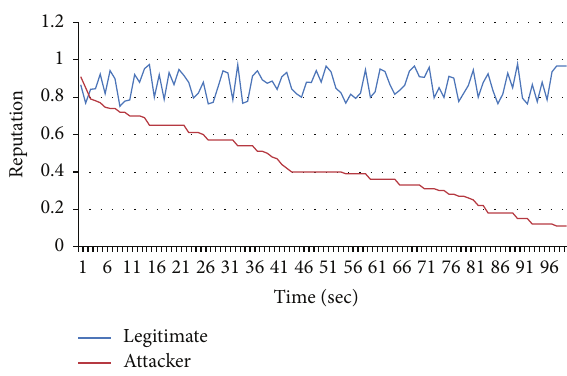
Figure 9: Reputation of both regular and jammer node over time.